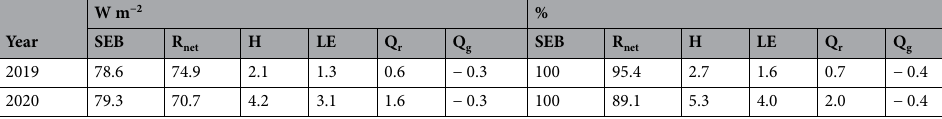
Table 2. Components of the surface energy balance (SEB) of the glacier for the period from 7 July to 23 August